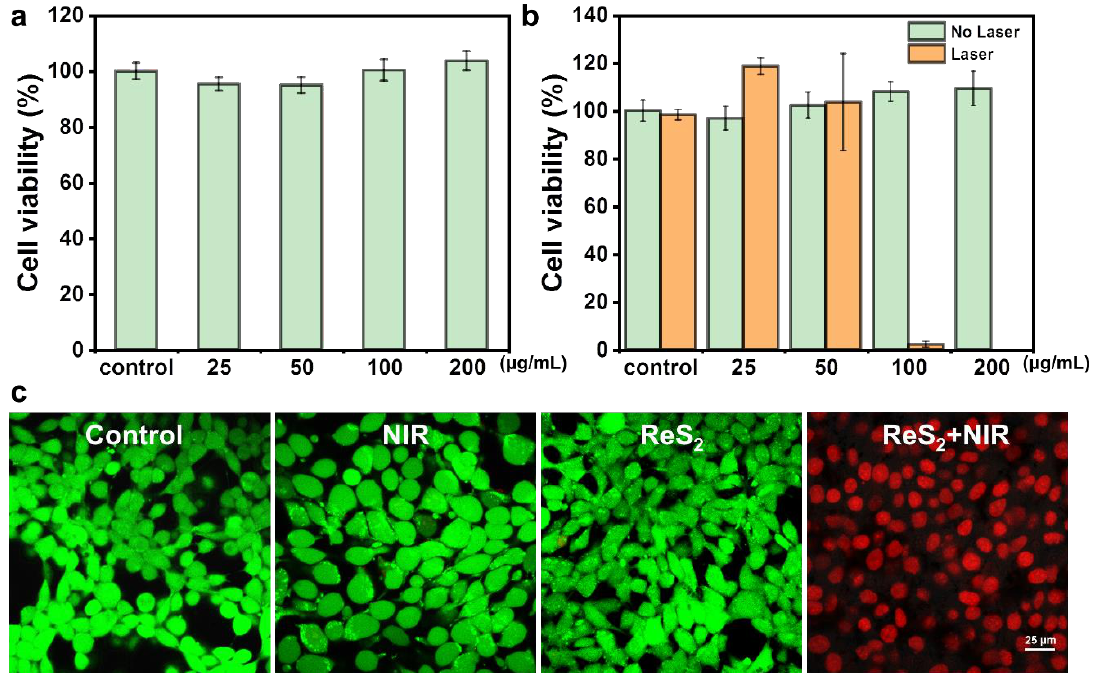
Figure 3. ( a ) Relative 4T1 cell viabilities after incubation with various concentrations of PEG-ReS 2 nanosheets (0, 25, 50, 100, 200 μg/mL) for 24 h. ( b ) Relative 4T1 cell viabilities after incubation with various concentrations of PEG-ReS 2 nanosheets (0, 25, 50, 100, 200 μg/mL) and irradiation with an 808 nm laser (1 W/cm 2 ) for 5 min. ( c ) Confocal images of treated 4T1 cells (Control, NIR, ReS 2 , and ReS 2 + NIR) co-stained by calcein AM (green fluorescence) and PI (red fluorescence) solutions. Next, we examined the effects of the PEG-ReS 2 nanosheets in our in vivo PTT model. We constructed an orthotopic breast tumor model by subcutaneously injecting 4T1 cells into the breast pad of BALB/c mice. When the tumors reached a size of approximately 80 mm 3 , the tumor-bearing mice were divided into four groups: (Group 1) Control; (Group 2) NIR; (Group 3) ReS 2 ; and (Group 4) ReS 2 + NIR. Group 1 and Group 2 mice were intratumorally injected with 100 µ L PBS solution, while Group 3 and Group 4 mice were intratumorally injected with 100 µ L PEG-ReS 2 (2 mg/mL) nanosheet solution. Group 2 and Group 4 mice were anesthetized and their tumor sites were treated with an 808 nm laser (0.5 W/cm 2 ) for 10 min. During the PTT process, the real time temperature at the tumor sites was instantaneously recorded by infrared thermography (Figure 4a). During the 10-min laser treatment, the temperature at the Group 2 tumor sites increased from 32.6 °C to 41.7 °C, an increment of 9.1 °C. However, in Group 4 mice, the real time temperature at the tumor sites increased significantly from 35.5 °C to 64.6 °C, a temper- ature increment of 29.1 °C (Figure 4b). Previous studies have reported that [51] tumor cells can be ablated at temperatures higher than 48 °C in 5 min, due to the high temper- ature producing irreversible cell death of the tumor tissue. In the present study, our findings indicated that the high temperature generated by PEG-ReS 2 nanosheets effi- ciently ablated the breast tumor after 10 min of PTT. The phototherapy outcome was preliminarily evaluated by investigating the H&E stained tumor slice images one day after treatment. As shown in Figure S1, the tumor tissue in Group 4 mice was seriously damaged and burned after exposure to the high temperature. Moreover, H&E staining of the Group 4 tumor slices revealed that the cell nuclei were broken and smaller than the normal morphology observed in the tumor slices from the other three groups (Figure 4c).